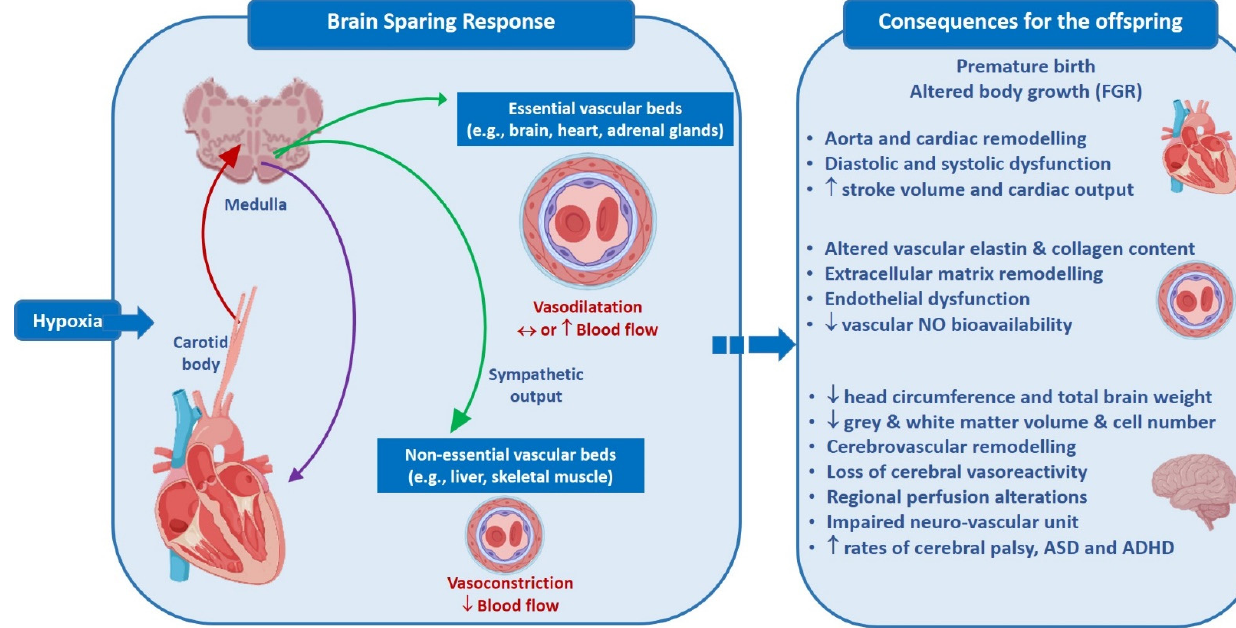
Figure 1. Brain sparing and consequences for the offspring. The fetus responds to hypoxia via afferent signals (red arrow) by redistributing blood flow to essential vascular beds (via efferent output, green arrows), a process known as brain sparing. Vagal control (purple arrow) decreases heart rate. This leads to a number of consequences in the fetus, particularly in the cardiovascular and cerebrovascular systems. Abbrev: autism spectrum disorder, ASD; attention deficit disorder (ADHD).